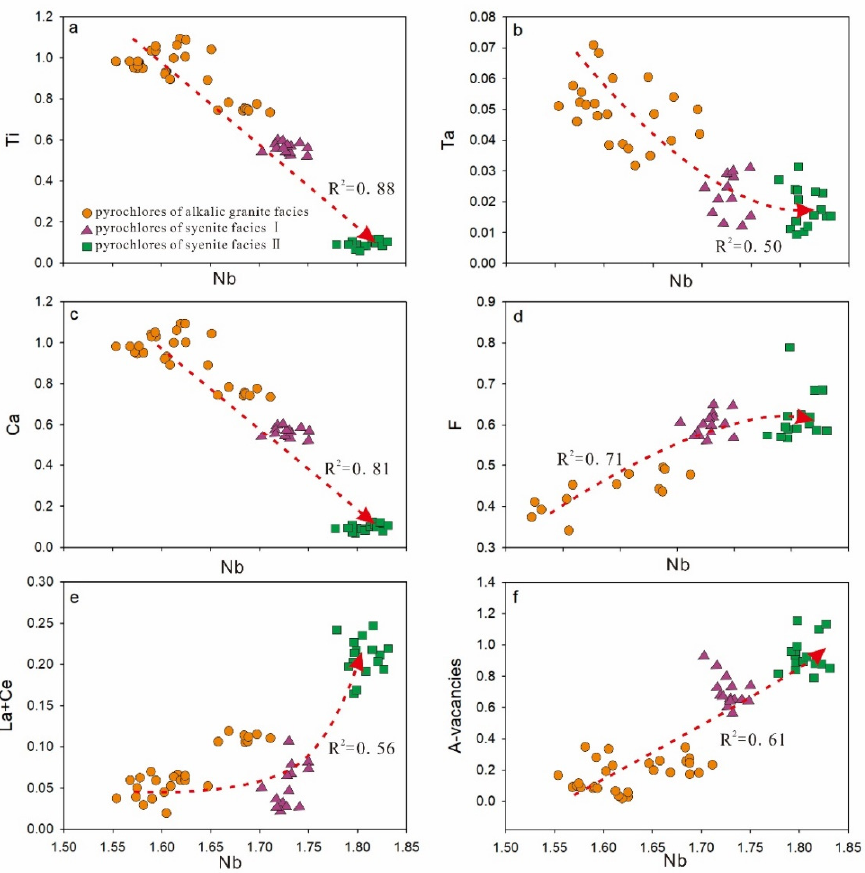
Figure 5. Variation in selected elements (apfu) in pyrochlore supergroup minerals from Boziguoer deposit. ( a ) Ti is negatively correlated with Nb, R 2 is 0.88; ( b ) Ta is negatively correlated with Nb, R 2 is 0.50; ( c ) Ca is negatively correlated with Nb, R 2 is 0.81; ( d ) F is positively correlated with Nb, R 2 is 0.71; ( e ) La+Ce is positively correlated with Nb, R 2 is 0.56; ( f ) A-vacancies is positively correlated with Nb, R 2 is 0.61.